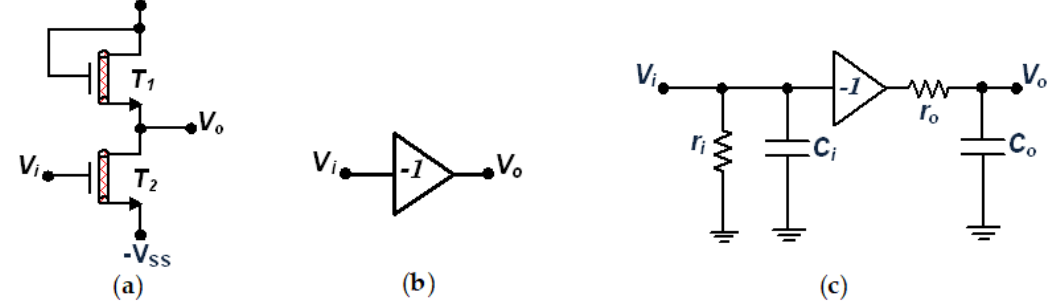
Figure 3. CNFET based UGIA: ( a ) Transistor-level realization; ( b ) Symbol; ( c ) Parasitic